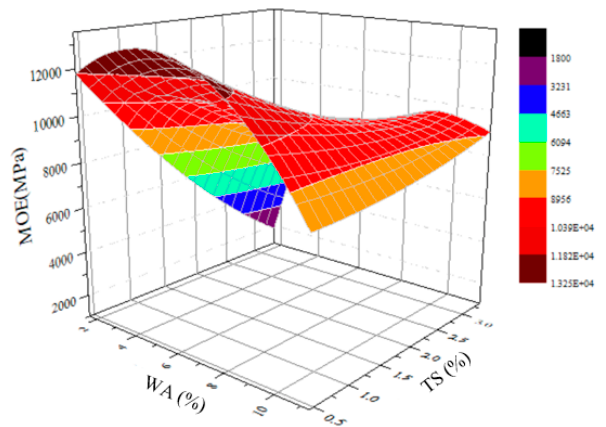
Figure 8. An empirical 3D model describing the relationship between MOE, TS, and WA of BS at 23 °C.